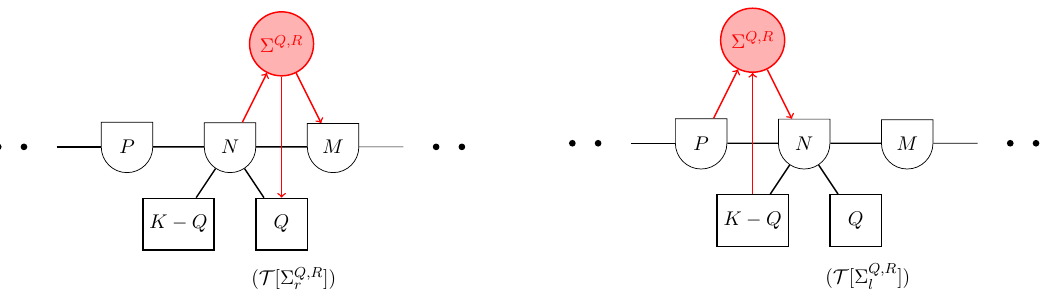
Figure 17 . The right SQM Σ Q,R realize a vortex defect V numbers of fundamental and anti-fundamental chiral multiplets for the terminal gauge